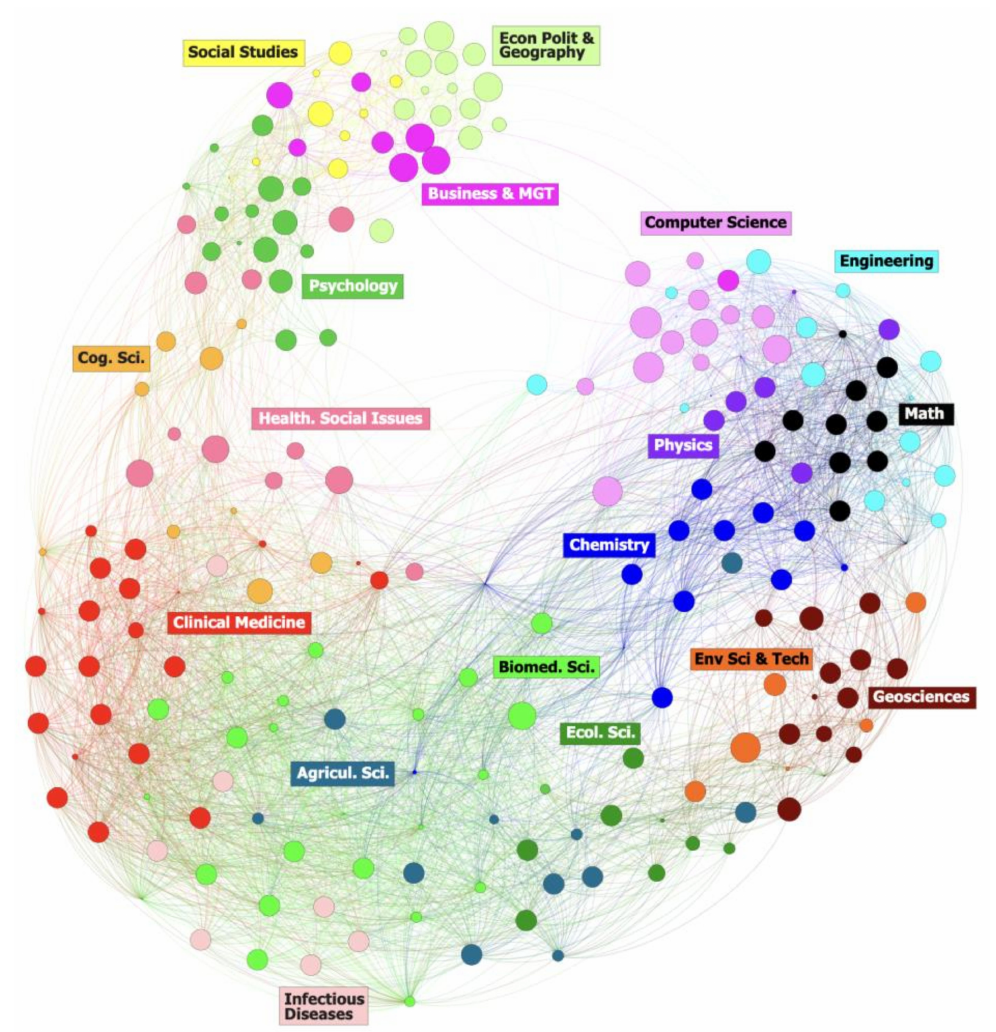
Figure 3. Subject Categories of social sciences articles between the years 2015–2020, based on the Big Data and AI analytics search terms. Source: WoS (11,007